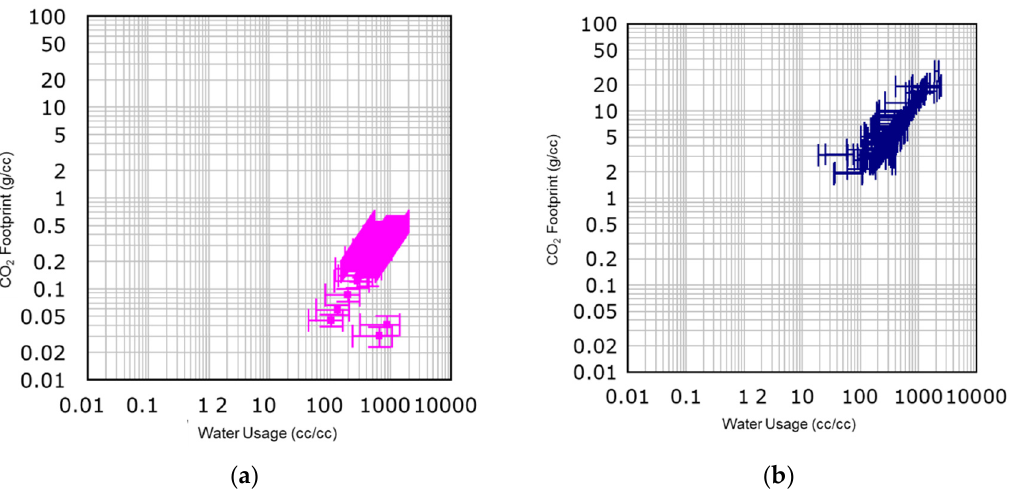
Figure 7. Big data regarding the sustainability of two families of materials. ( a ) Wooden materials, and ( b ) polymers [36].